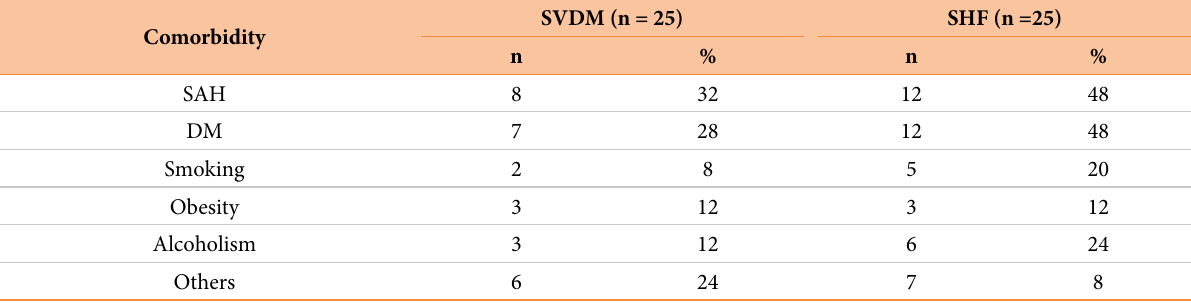
Table 4 - Distribution of comorbidities according to groups.